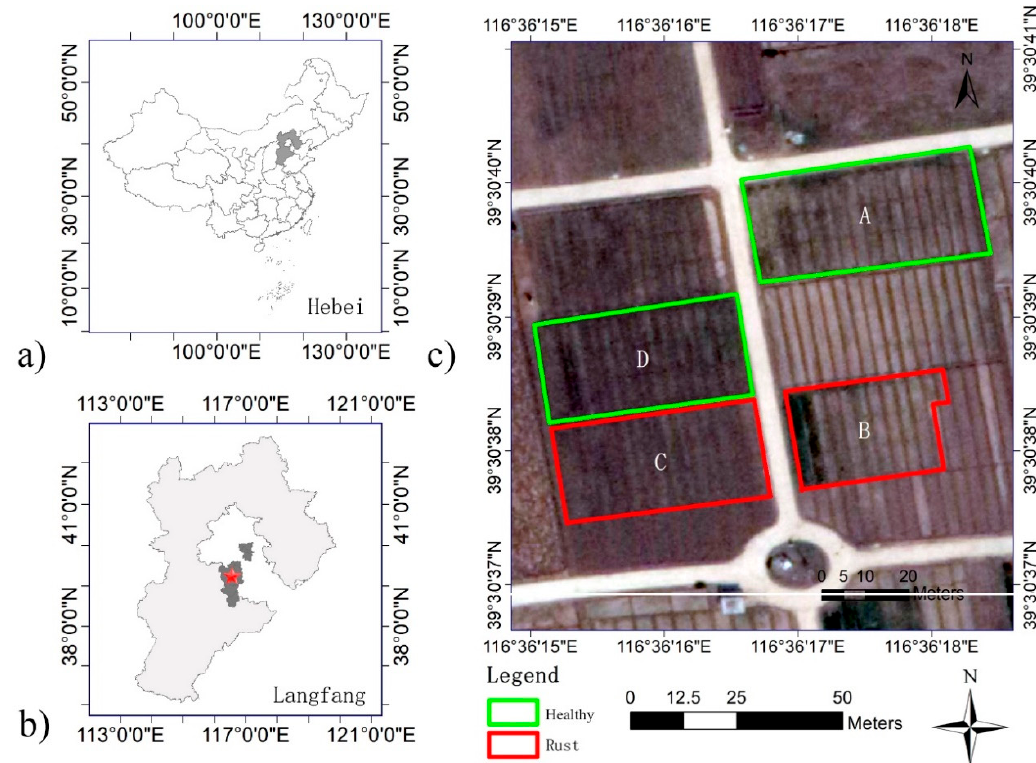
Figure 1. Study area: ( a ) the location of Hebei Province (dark grey region in the map); ( b ) the location of Langfang (dark grey region), Hebei Province, and the location of data collection (red star); ( c ) an image of winter wheat fields captured with UAVs. Four plots of winter wheat are identified with rectangular borders, two yellow rust plots within red rectangular borders and two healthy wheat plots within green rectangular borders.